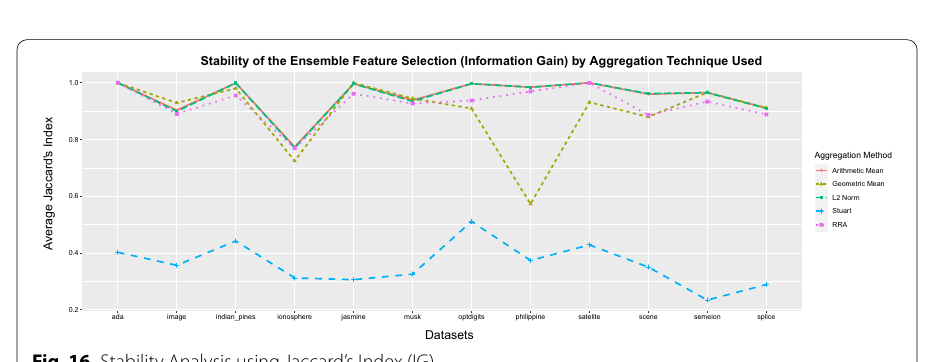
Stability of the Ensemble Feature Selection (Information Gain) by Aggregation Technique Used